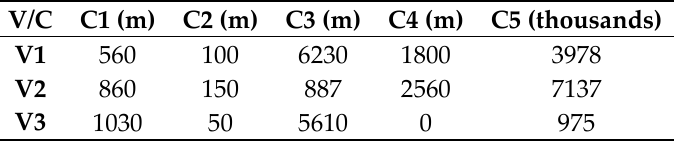
Table 1. Decision table. (Source: own work).